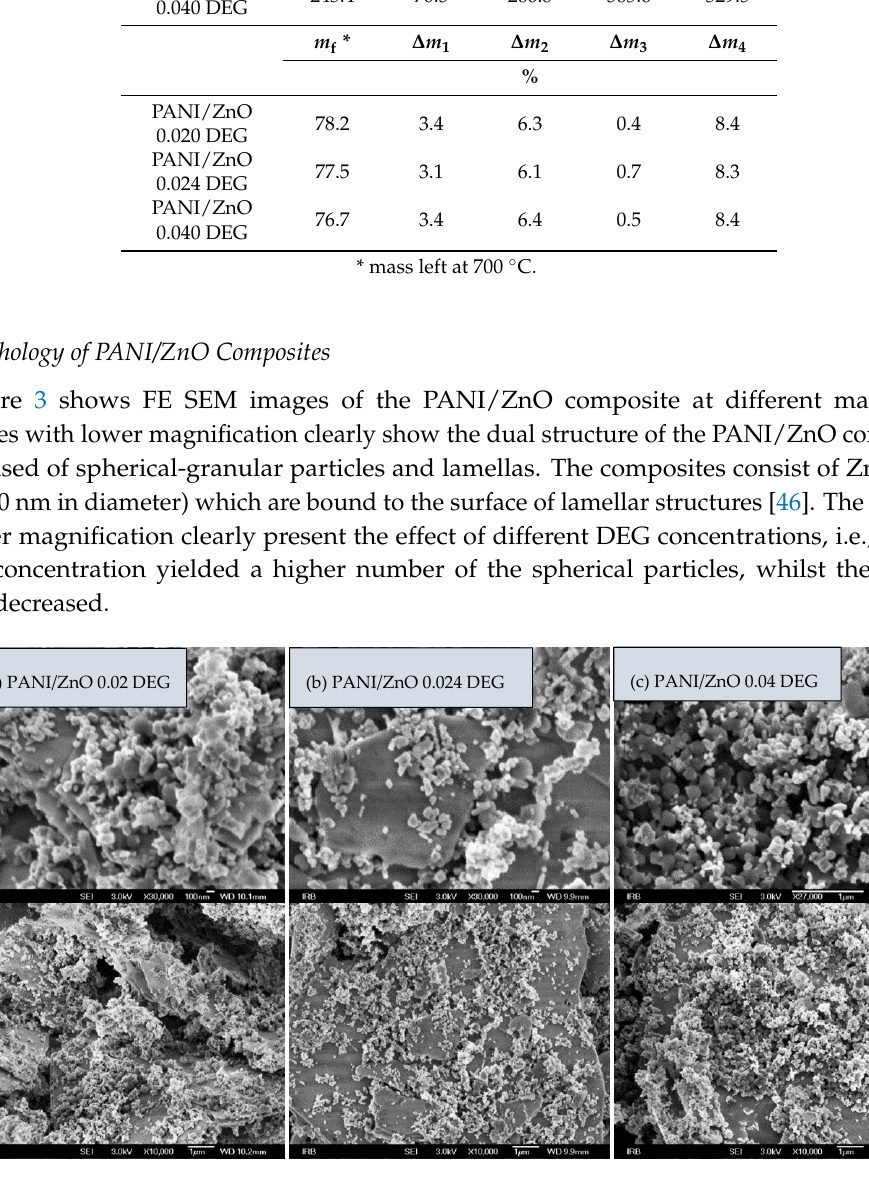
Figure 3. FE SEM images of the PANI/ZnO composites at different magnifications ( up ) X30.000 and ( down ) X10.000. Images show the impact of different diethylene glycol (DEG) concentrations on in situ composites synthesis.